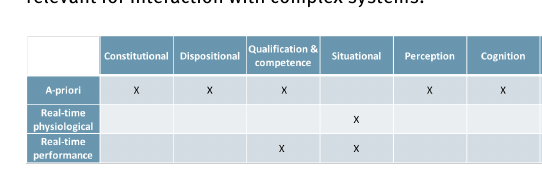
Table 1: Measurement methods with respect to human capabilities relevant for interaction with complex